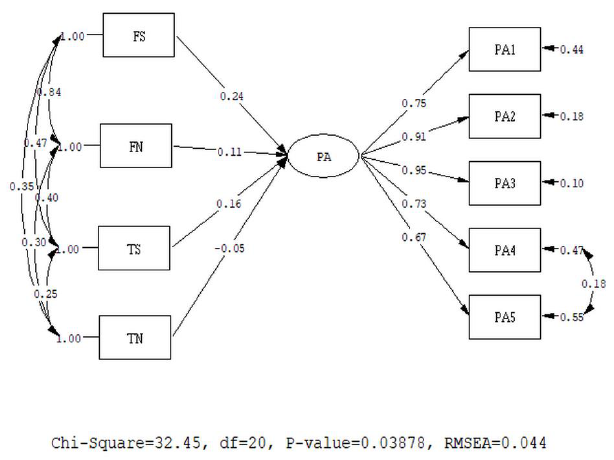
Figure 3. MIMIC model of Positive A ff ect Schedule